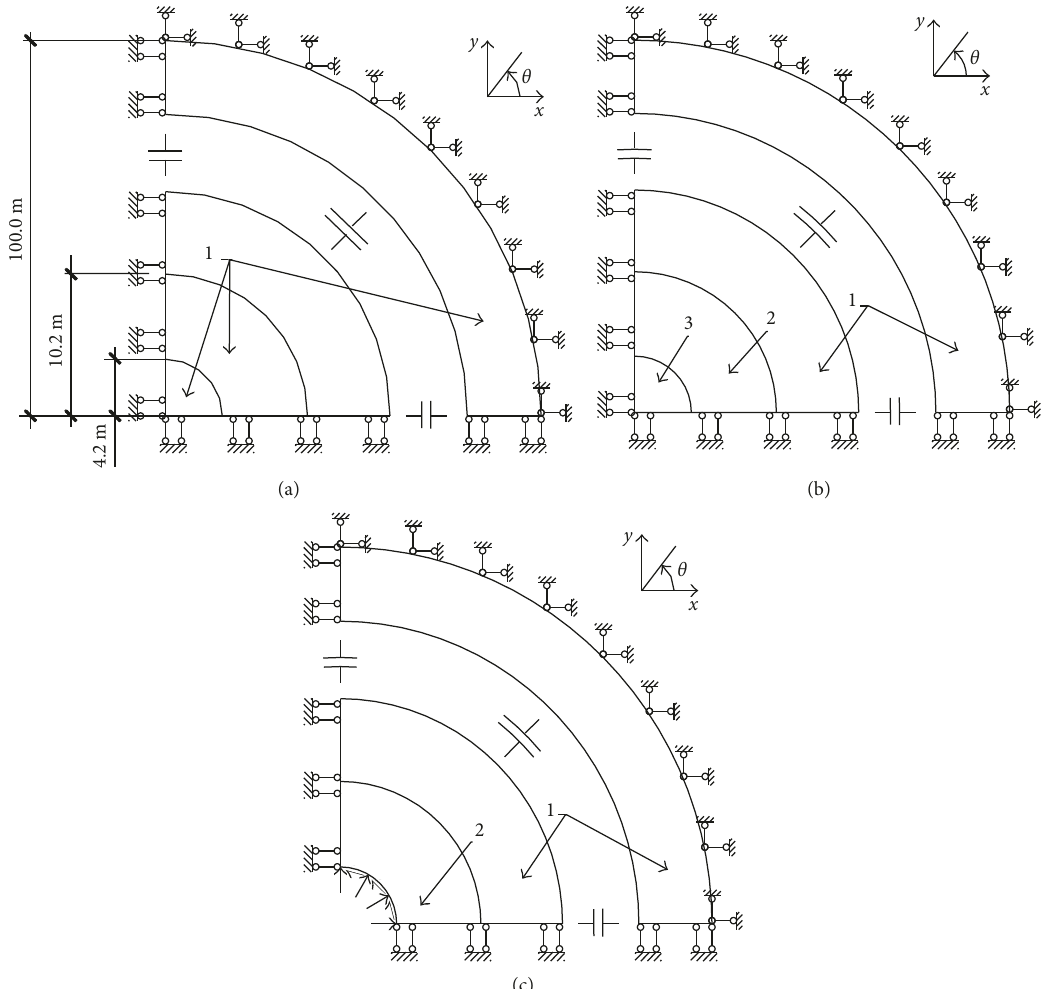
Figure 4: Schematic diagram of finite-element model: (a) before freezing; (b) after freezing and before excavation; (c) after excavation. 1, unfrozen rock; 2, frozen wall; 3, rock to be